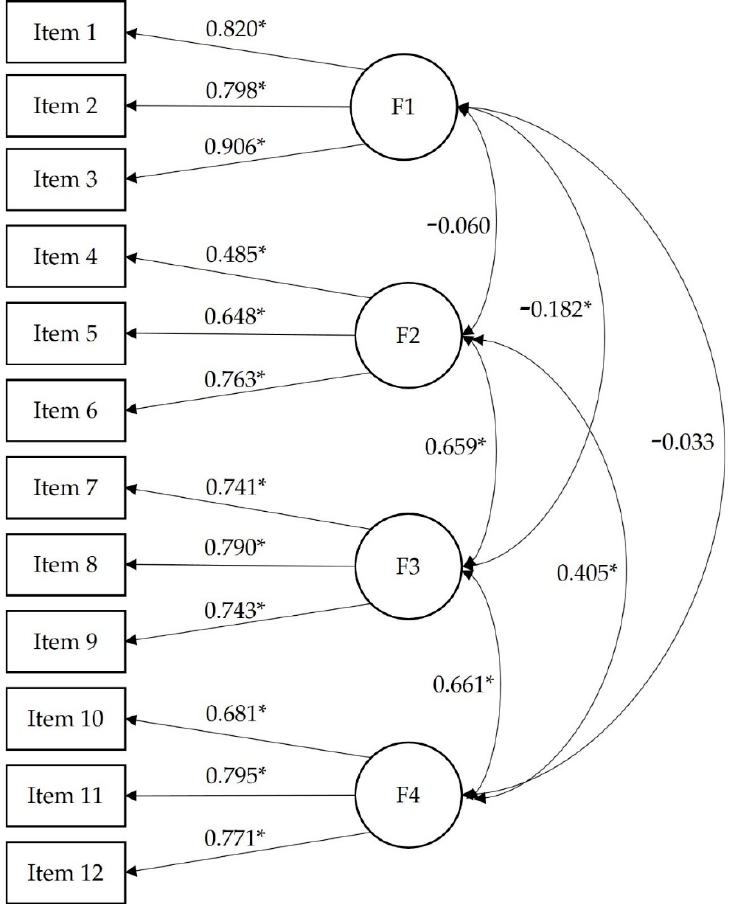
Figure 1. Standardized coefficients for the four-factor model of the Vaccination Attitudes Examination scale. Note: F1 = trust of vaccine benefit; F2 = worries over unforeseen future effects; F3 = concerns about commercial profiteering; and F4 = preference for natural immunity. * p < 0.001.